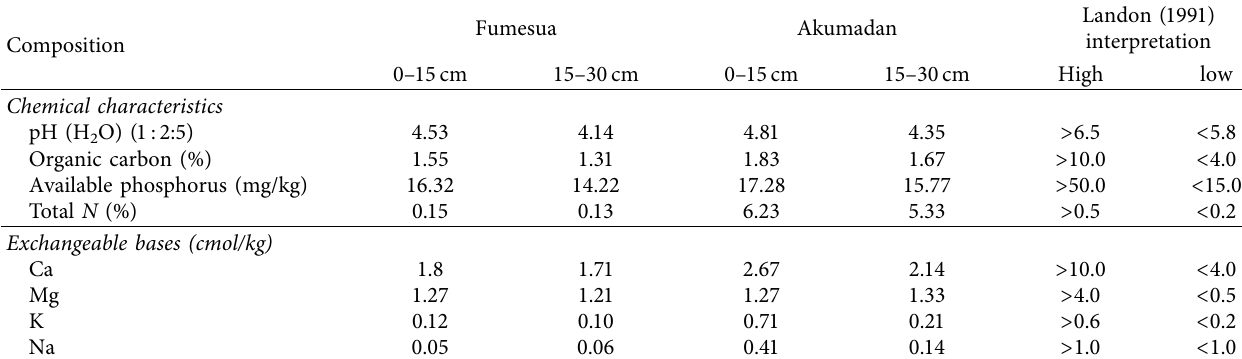
Table 1: Initial soil chemical properties at the experimental